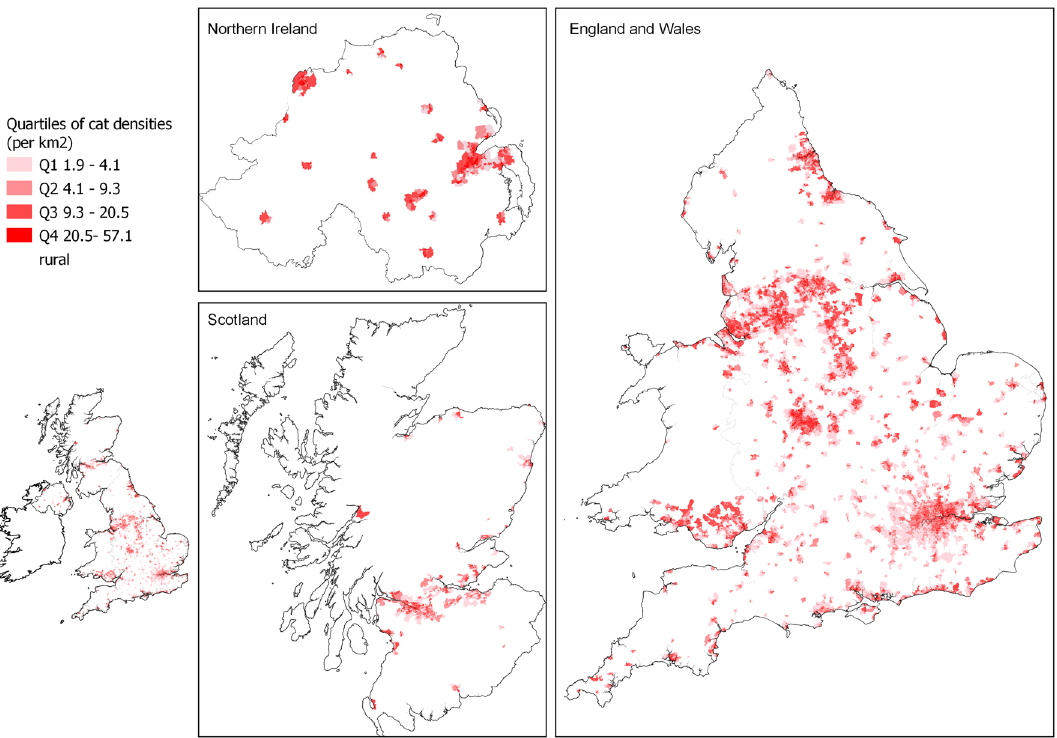
Figure 3. Density of unowned cats across urban areas in the UK. Density predicted from applying the posterior distributions of effect sizes derived from the IAM to IMD quintiles and population density for urban small area geographies. Mean values are shown. Countries are displayed separately according to their different urban geographical units. For visualisation purposes, some islands that do not include any urban areas are excluded from the plot. Map was generated using QGIS 3.16 (https:// www. qgis.